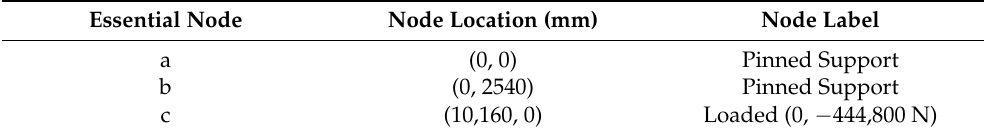
Figure 4. Design domain for experiment 1. Table 1. Essential node information in experiment 1.